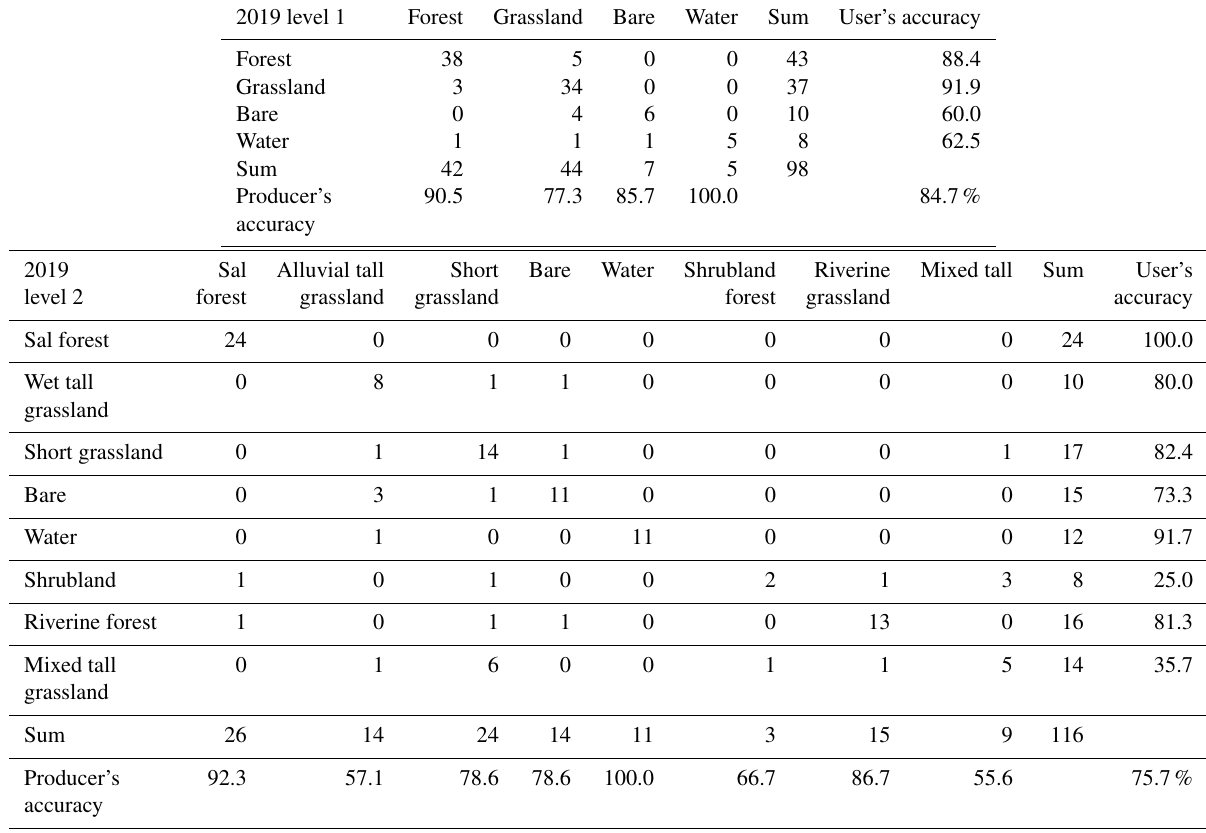
Table E1. Confusion matrices of the level 1 and level 2 classifications for 2019, as calculated with 30% of the ground truth data and confusion matrices for 2000, 2010, 2011 and 2018 based on a separate validation set (106